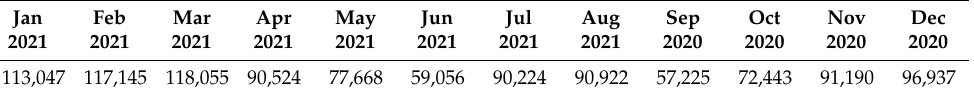
Table 2. Energy consumption of metallurgy company in month resolution for each month in kWh.